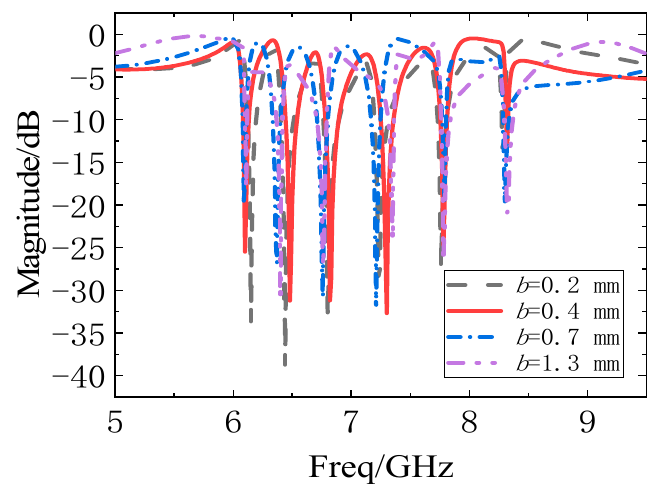
Figure 15. Resonance curves when the resonator spacing b is changed. The resonance characteristics of tags with different dielectric constants (Figure 16) and dielectric thicknesses (Figure 17) are studied to directly print the chipless tag of the U-shaped slot resonator structure on materials of different thicknesses, like a barcode. Figure 16 shows that, when the dielectric constant of the medium is 2.2, 2.55, 2.65, and 3.0, the resonance frequency decreases with increasing dielectric constant ε r . When the printed materials are different, the frequency position needs to be re-encoded, and the frequency position code of the reference tag needs to be re-encoded. Figure 17 illustrates the tag resonance curve obtained by changing the substrate thickness from 0.5 mm to 2 mm in steps of 0.5 mm. The resonance frequency corresponding to the U-shaped slot resonator changes slightly when the thickness is changed, but the resonance frequency increases as the thickness increases.